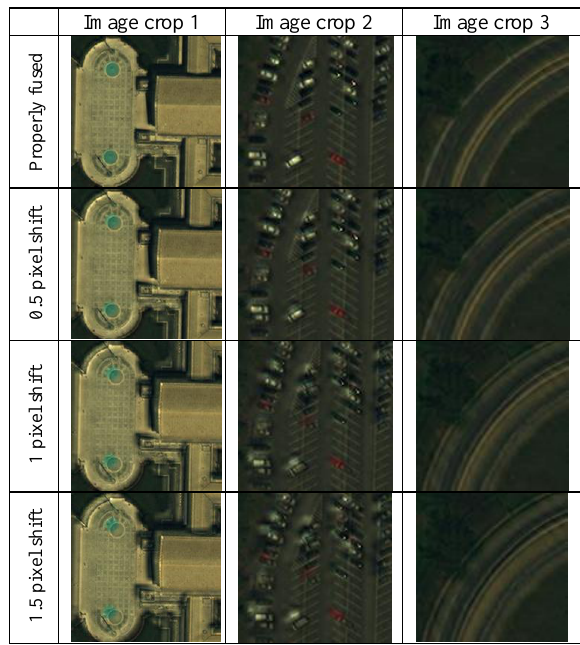
Figure 7. Image crops of error-free and distorted fused images, pan-sharpened by WWI method.